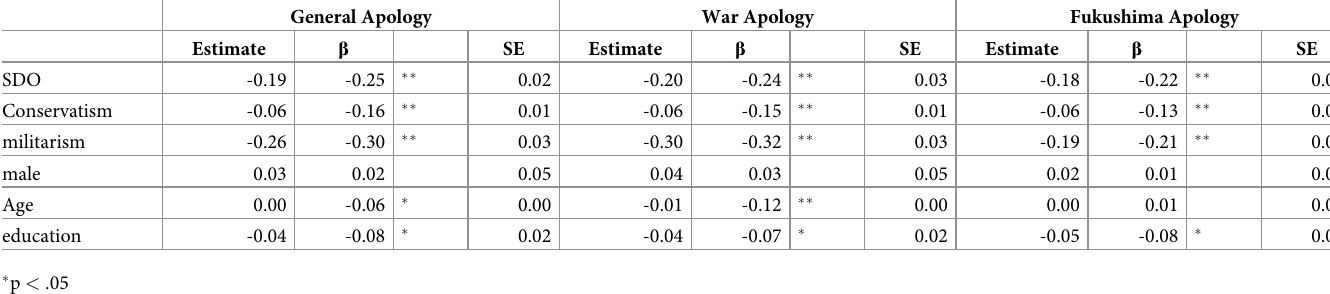
Table 2. Multiple regression models on